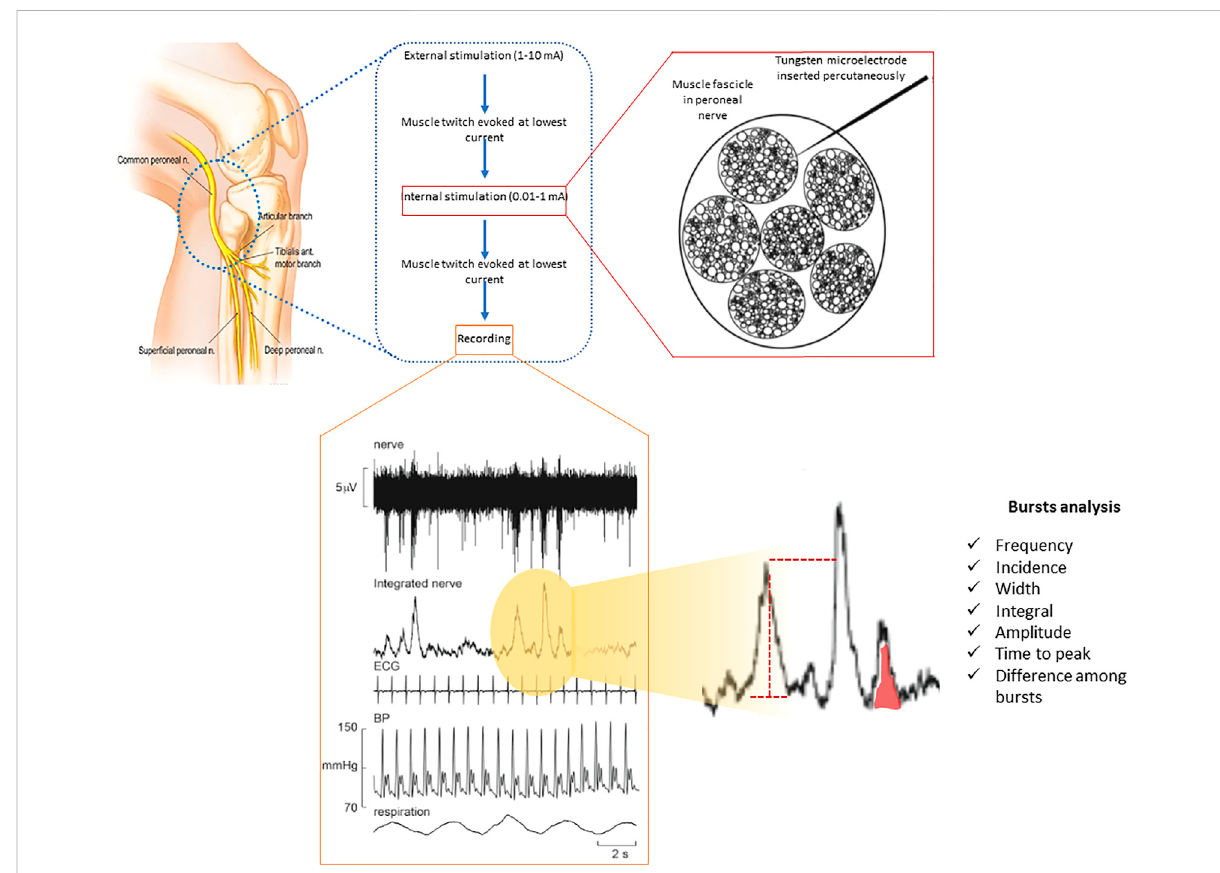
FIGURE 1 Multi-unit recording of muscle SNA from a healthy participant via a tungsten microelectrode inserted percutaneously into a muscle fascicle of the peroneal nerve, shown schematically on the left. Muscle SNA occurs as bursts with a clear cardiac rhythmicity. Heart rate and diastolic blood pressure variability can be derived from the setup used through ECG and continuous ( fi nger) blood pressure all being recorded